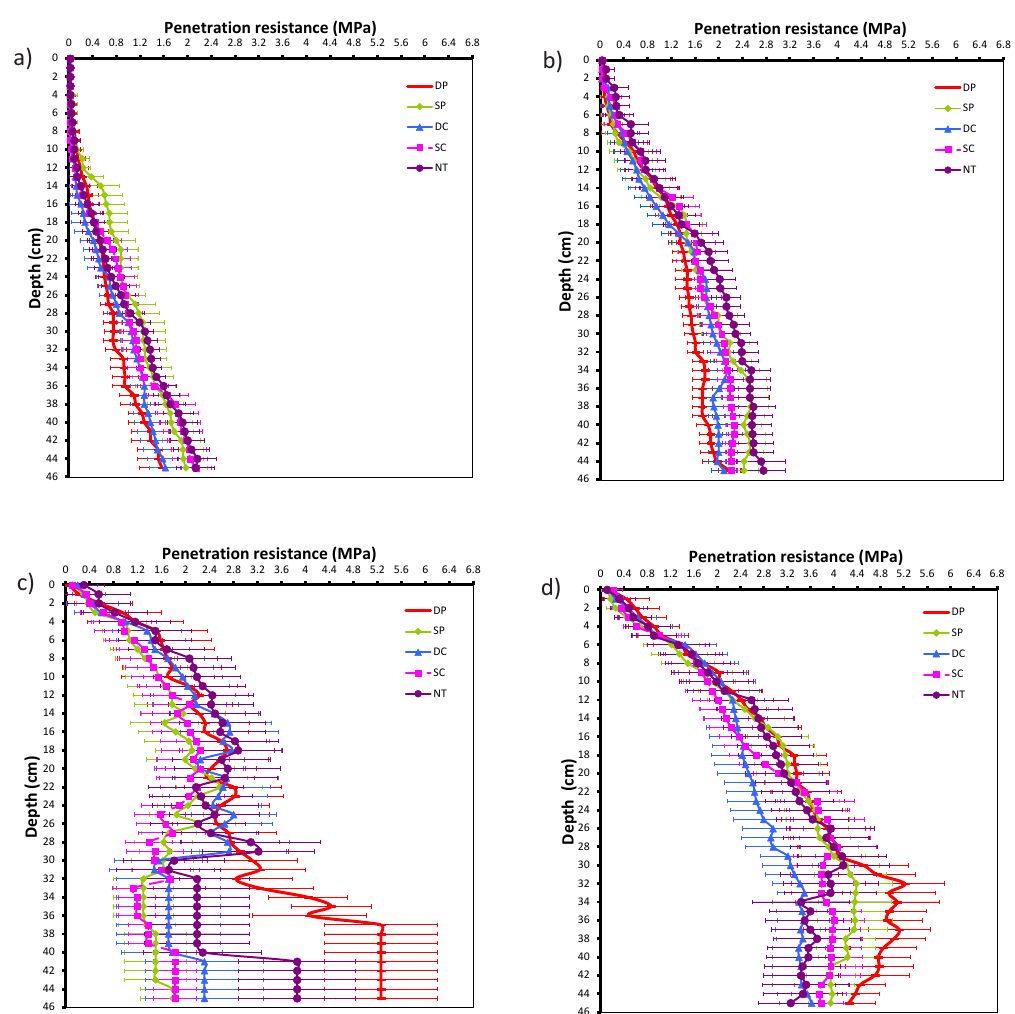
Fig. 3. Soil penetration resistance at different stages of experiment in 2018: a) before pre-sowing tillage in spring; b) after faba bean sowing; c) beginning of faba bean flowering; d) after harvesting. DP = deep ploughing, SP = shallow ploughing, DC = deep cultivation, SC = shallow cultivation, NT = no-tillage (direct